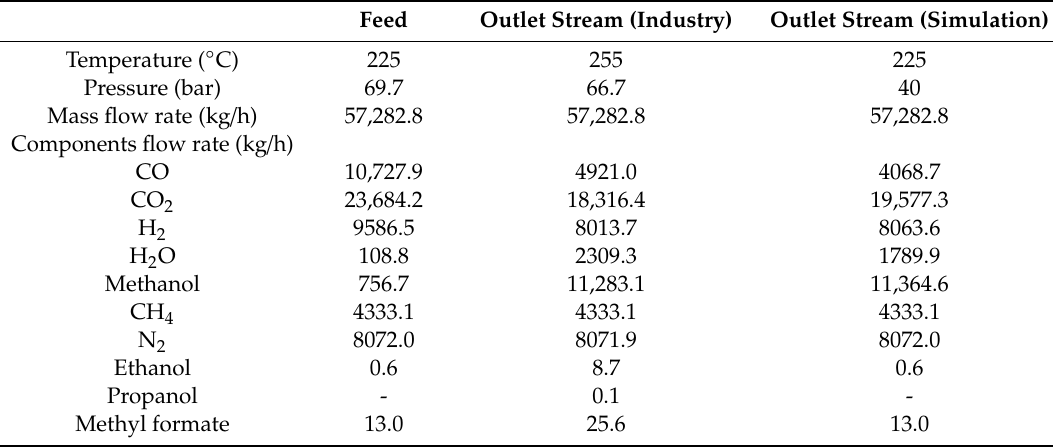
Table 7. Comparison between simulated and industrial results of methanol yield.